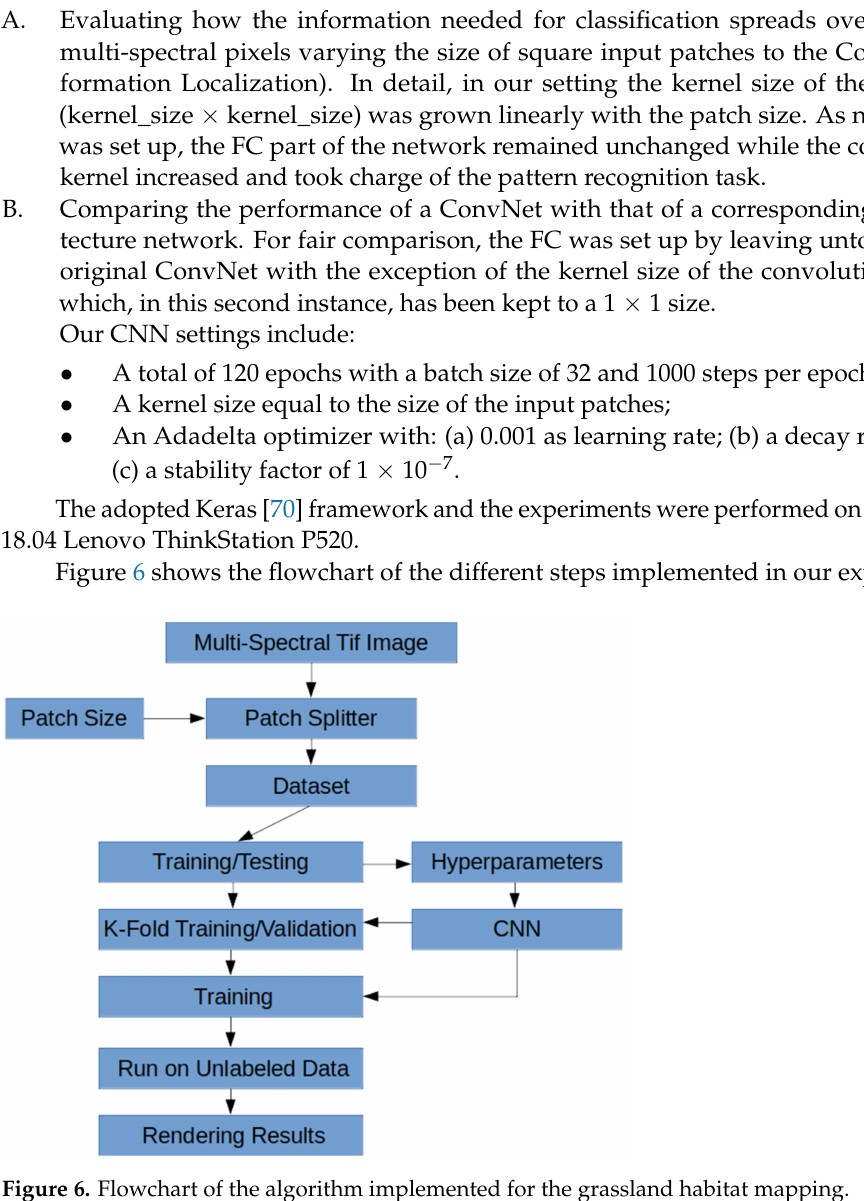
Figure 6. Flowchart of the algorithm implemented for the grassland habitat